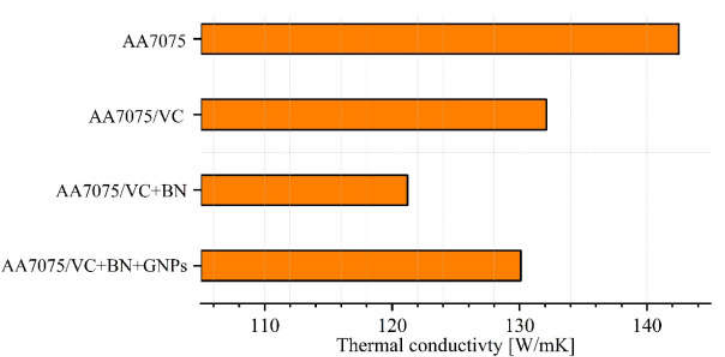
Figure 7. The thermal conductivity of the base alloy AA7075 and the manufactured